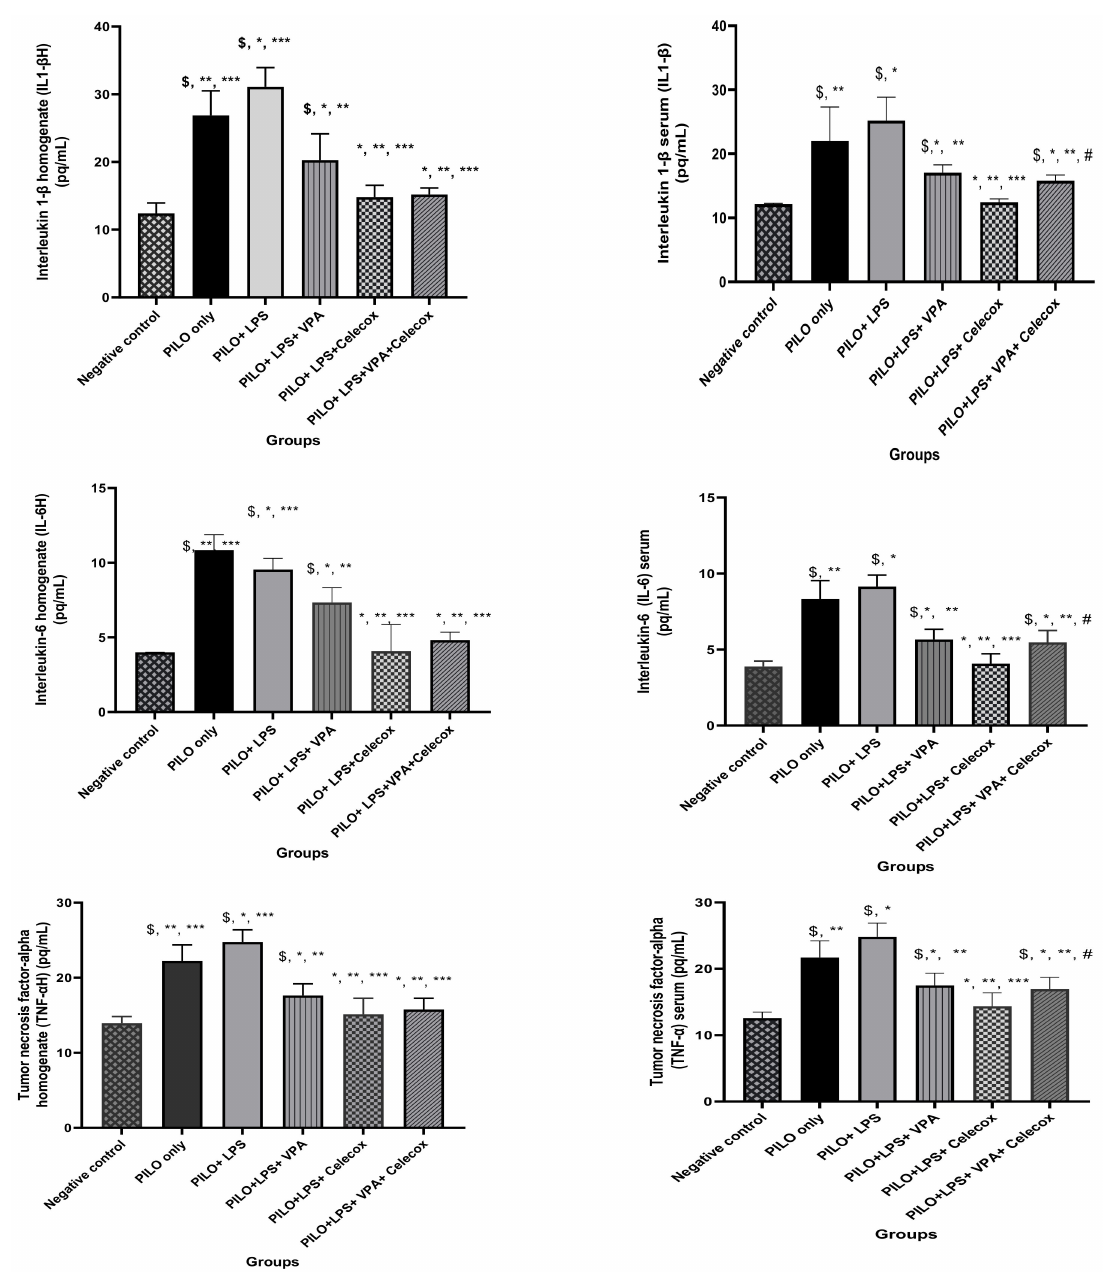
Figure 3. Effects of tested drugs on serum and homogenate levels of pro-inflammatory cytokines in rats of different groups. Data were expressed as mean +/ − standard deviation. PILO: pilocarpine, LPS: lipopolysaccharides; VPA: valproic acid, Celecoxib: celecoxib. Comparison between groups was made using One-way ANOVA test followed by Tukey’s multiple comparison test. * p < 0.05 comparison versus PILO only; ** p < 0.05 comparison versus PILO+LPS, *** p < 0.05 comparison versus PILO+LPS+VPA, # p < 0.05 comparison versus PILO+LPS+Celecoxib, $ p < 0.05 comparison versus negative control